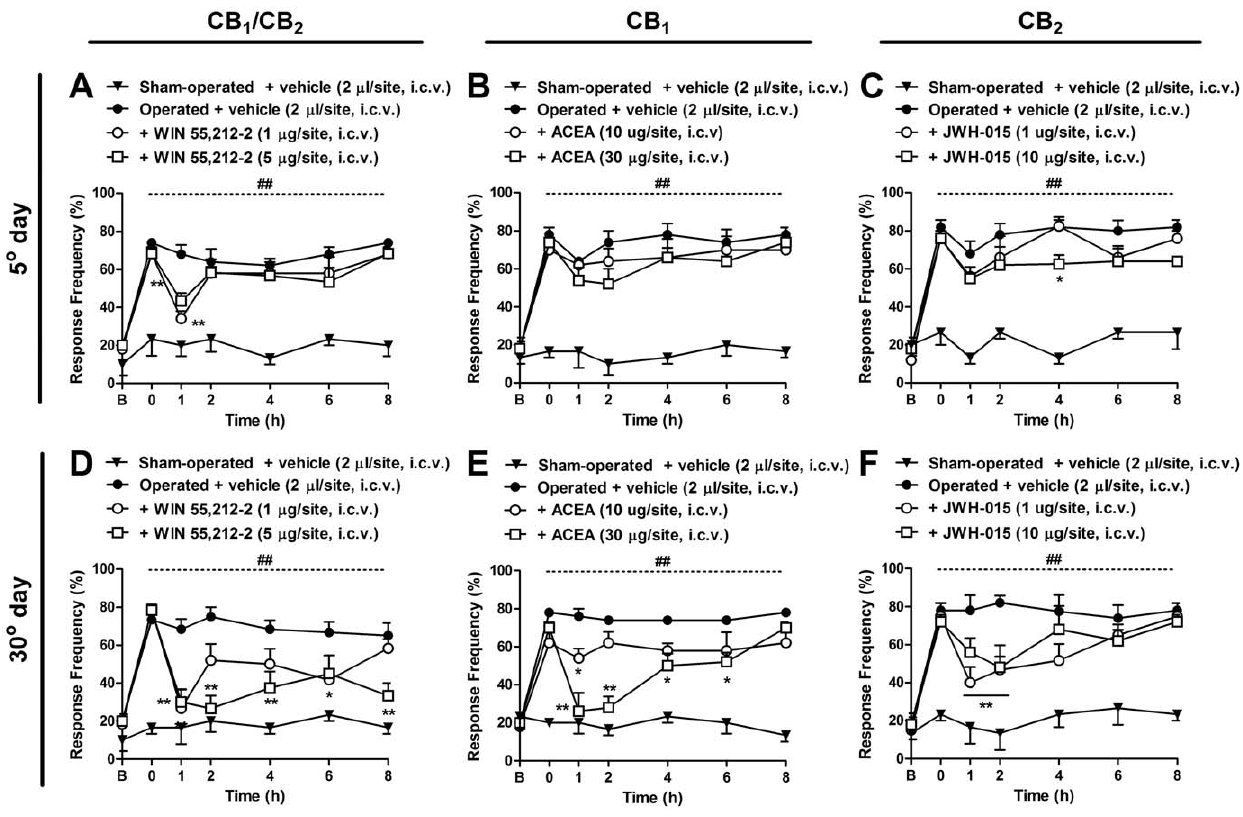
Figure 7. Effects of supraspinal (i.c.v.) treatment with cannabinoid agonists on mechanical allodynia induced by brachial plexus avulsion (BPA). Response frequency of the right hindpaw assessed at several time-points in operated (BPA) mice treated with the non-selective CB 1 and CB 2 agonist, WIN 55,212-2 (1–5 m g/site, i.c.v.), the selective CB 1 agonist, ACEA (10–30 m g/site, i.c.v.), the selective CB 2 agonist, JWH-015 (1–10 m g/ site, i.c.v.) or vehicle (2 m l/site, i.c.v.), administered on the 5 th (A, B and C) or 30 th (D, E and F) day after surgery. Data are expressed as mean 6 SEM (n=4–6/group). *p , 0.05 and **p , 0.01, significantly different from the operated group treated with vehicle (two-way ANOVA with Bonferroni’s post hoc test). B, Baseline withdrawal threshold before surgery. 0, baseline withdrawal threshold after surgery on the day of the experiment (5 th and 30 th days).